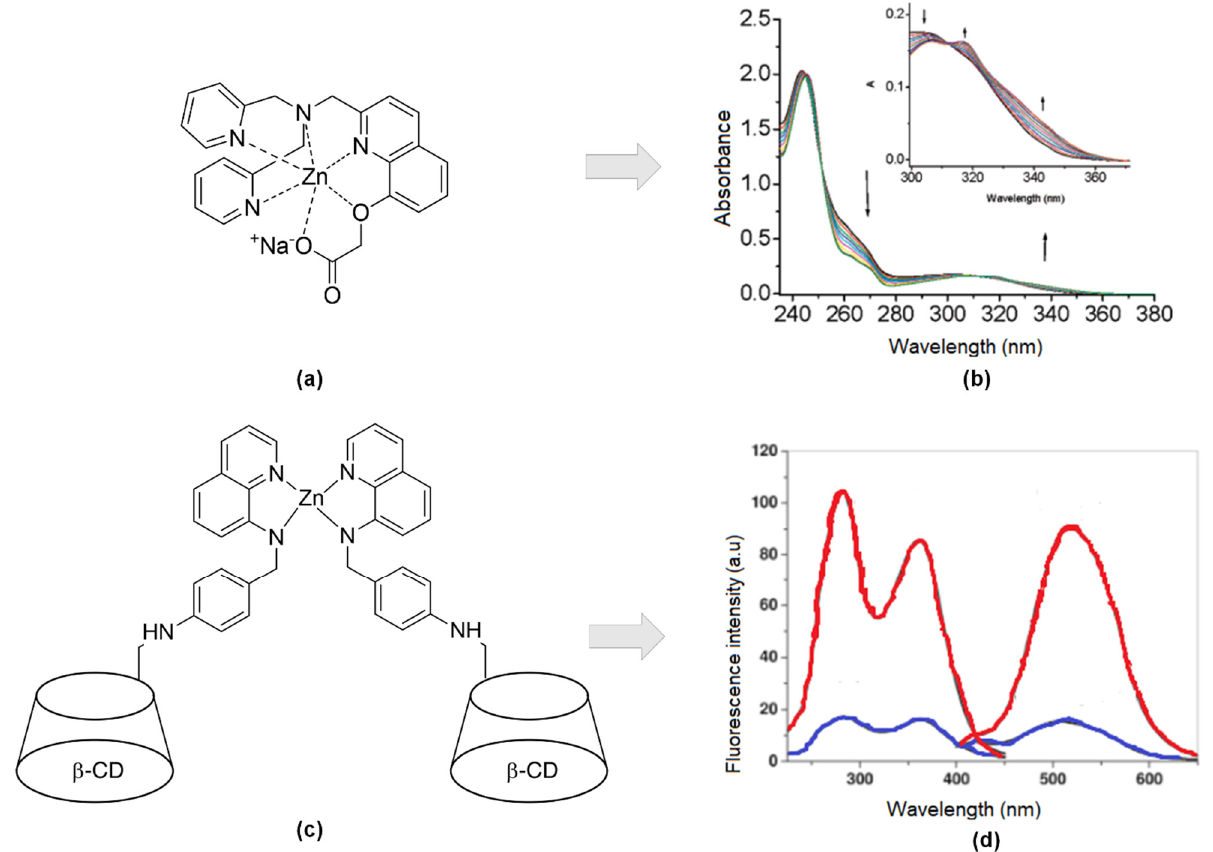
Figure 5. ( a ) Hexadentate of sodium 2-((2-((bis(pyridin-2-ylmethyl)amino)methyl)quinolin-8-yl)oxy)acetate (1) ligand-Zn; ( b ) Absorbance upon binding 0–1 equivalent to Zn 2+ (25 mM HEPES, 0.1 M NaClO 4 , pH 7.4, 25 °C). Inset: Focused absorbance between 300 to 370 nm. ( c ) Covalently linked 6-deoxy-6-formyl-ß-cyclodextrin(CD) into an analog of TSQ, N-(8-quinolyl)-p-aminobenzene -sulfonamide (HQAS)-Zn. ( d ) Excitation and emission without Zn 2+ (blue), with Zn 2+ (red) at λ ex = 285 nm and 362 nm, λ em = 507 nm.